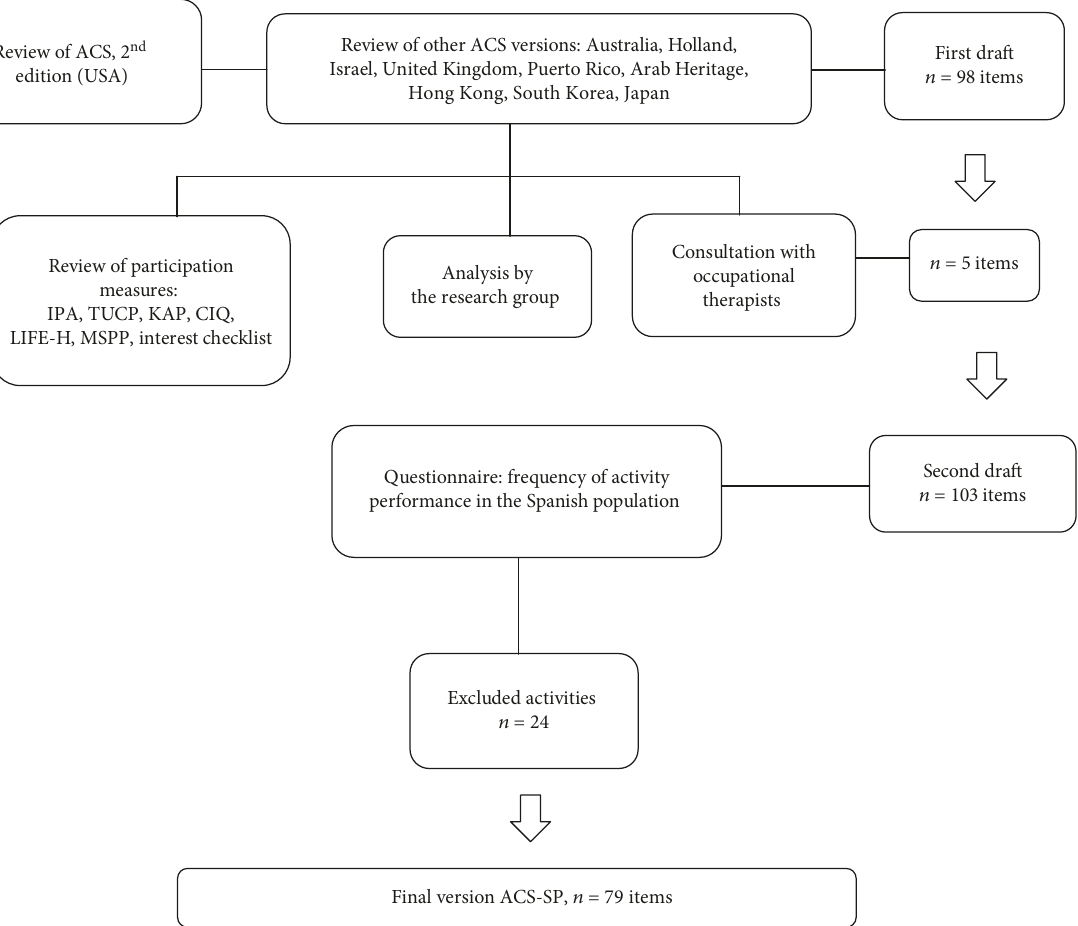
Figure 1: Adaptation process of the ACS scale to the Spanish